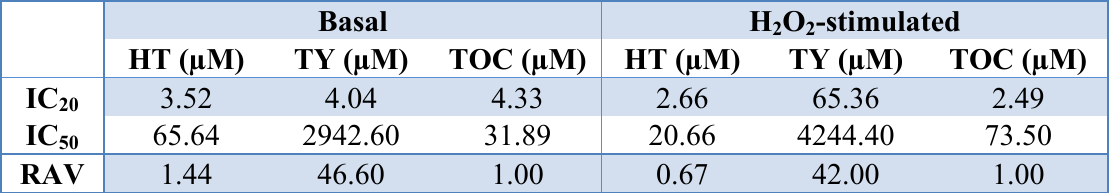
and IC values defined as the values 20 50 O -stimulated fluorescence in DCFH-DA assays 2 2